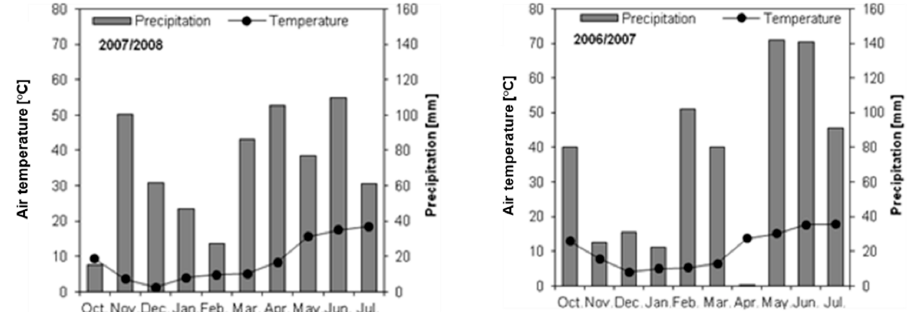
Figure 2. Air temperature ( ● ) and precipitation (bars) at the organic trial site Kleinhohenheim for the growing seasons 2006/2007 and 2007/2008.